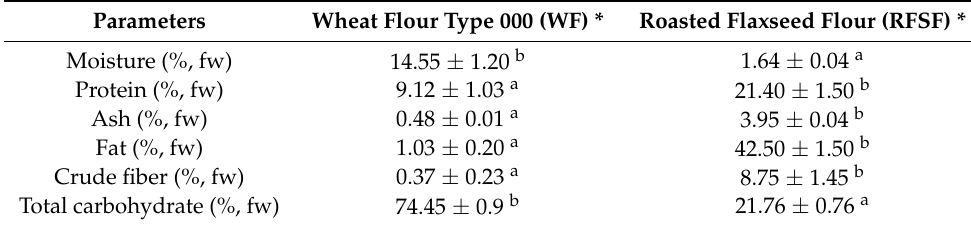
Table 2. Proximate composition of raw materials.